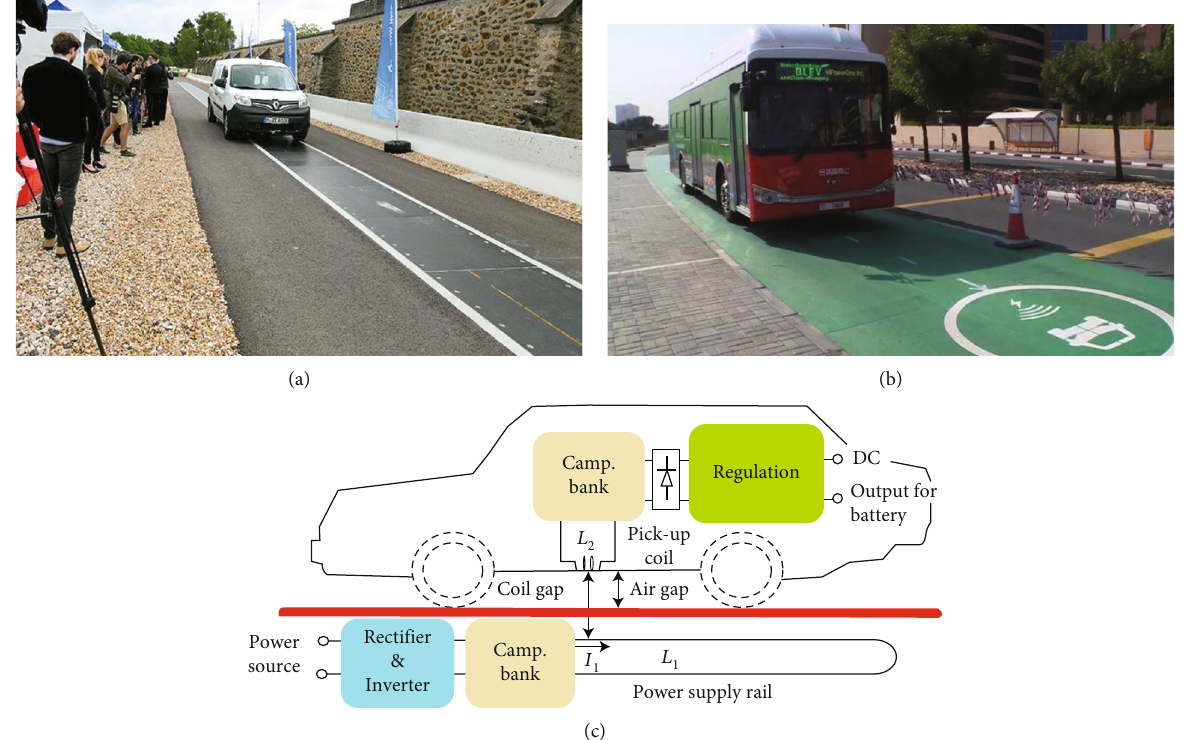
Figure 1: DWC vehicle on a test track and fundamental theory. (a) Source from Qualcomm Halo DEVC [27] and (b) Dubai Silicon Oasis charge vehicles [28]. (c) Source from 2GreenEnergy [20].